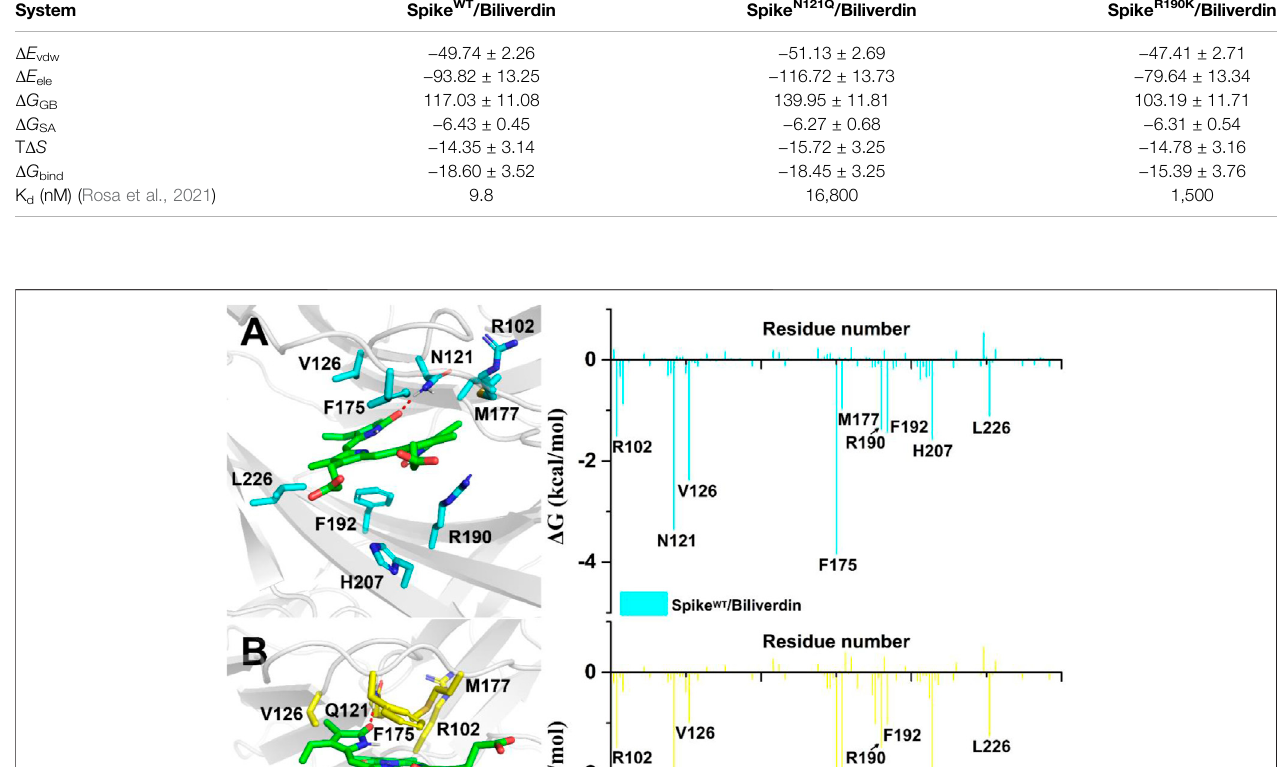
Frontiers in Molecular Biosciences |